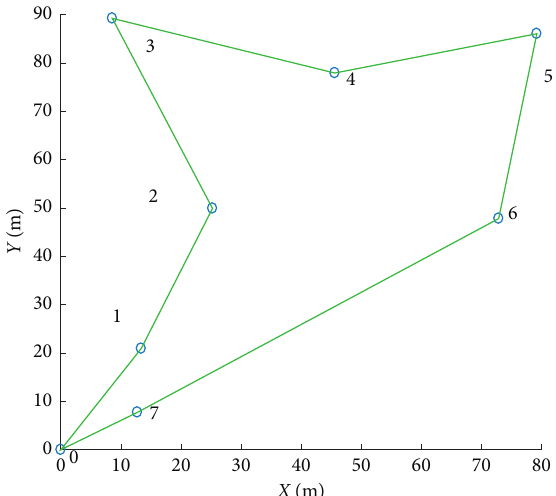
Figure 12: Planned access order in the second subcycle.